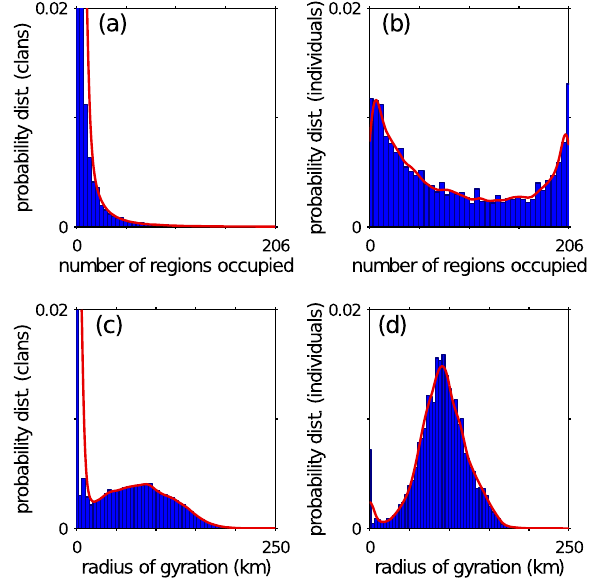
FIG. 19. (a) Probability distribution of the number of different administrative regions occupied by a Czech family name in 2009. Note that the two leftmost bars have heights of 0.17 and 0.03 (with 0.17 at the farthest left), but we have truncated them for visual presentation. (These data were initially analyzed in Ref. [25].) (b) Probability distribution of the number of different adminis- trative regions occupied by the clan of a Czech individual selected uniformly at random in 2009. The difference between this panel and the previous one arises from the fact that clans with larger populations tend to occupy more administrative regions. [That is, we select a clan uniformly at random in panel (a), but we select an individual uniformly at random in panel (b).] (c) Probability distribution of radii of gyration (in km) of Czech family names in 2009. Note that the leftmost bar has a height of 0.11, but we have truncated it for visual presentation. (d) Probability distribution of radii of gyration (in km) of Czech family names of a Czech individual selected uniformly at random in 2009. The difference between this panel and the previous one arises from the fact that clans with larger populations tend to occupy more administrative regions. Observe that the distributions in panels (a) and (b) are starkly different from the distributions in panels (a) and (b) from Fig. 3. Solid curves are kernel density estimates (from M ATLAB R2011a ’ s KSDENSITY function with a Gaussian smoothing kernel of width 5).